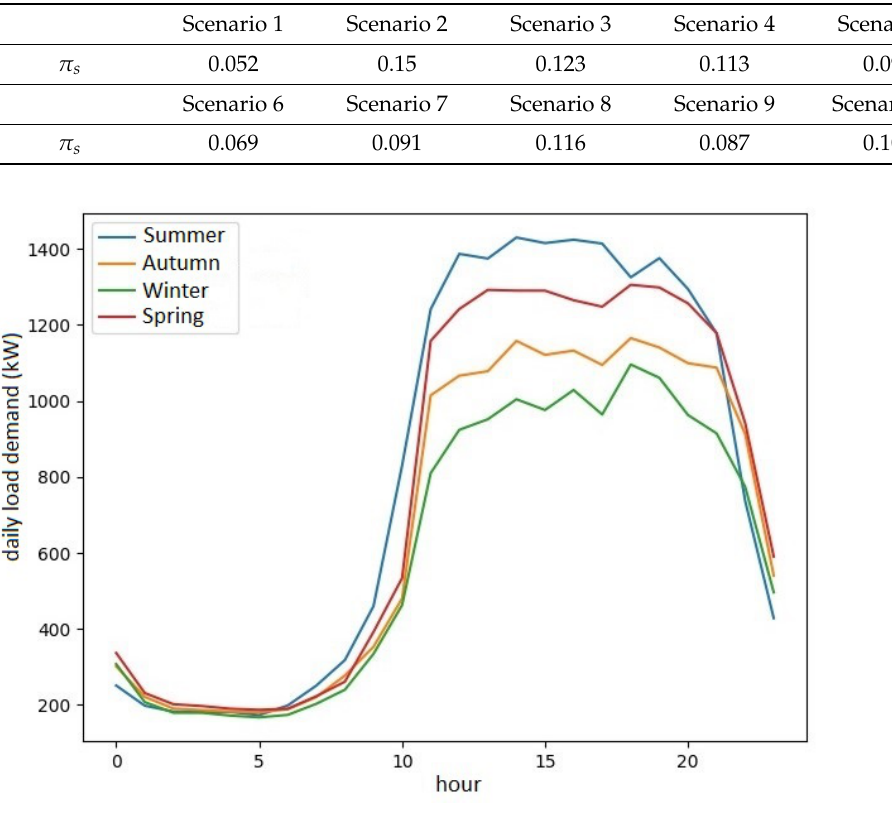
Figure 2. Daily load demand in the four seasons. The generation of the synthetic clearness index and PV power data for each represen- tative hour/day/quarter was fed by historical global radiation and temperature data from the National Institute of Meteorology (INMET)